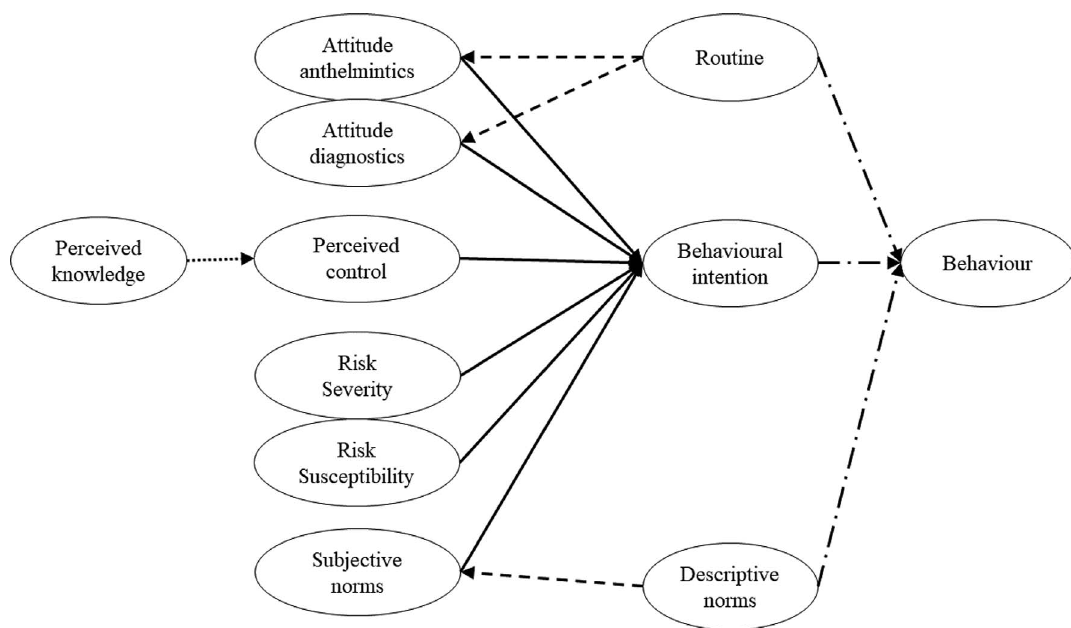
Figure 1. Conceptual model to predict dairy farmers ’ adoption of diagnostic methods for control of gastrointestinal nematode infections, based on the work by Vande Velde et al. (2015), and extended with insights from previous decision-making frameworks for parasite control. Notes. Full lines represent the equations informed by Vande Velde et al. (2015), dotted lines by Rose Vineer et al. (2017), short-dashed lines by Mingolla et al. (2019), dashed-dotted lines by Vande Velde et al. (2018). The following factors are included: Perceived knowledge (i.e., perception of the current knowledge one has on the context of control of gastrointestinal nematode infections); Perceived control (i.e., perceived ability to adopt diagnostics for control of gastrointestinal nematode infections); Routine (i.e., perception of the current treatment); Attitude diagnostics (i.e., evaluation of the expected outcomes to adopt diagnostics for control of gastrointestinal nematode infections); Attitude anthelmintics (i.e., evaluation of the expected outcomes to preventively treat with anthelmintics for control of gastrointestinal nematode infections); Descriptive norms (i.e., perception of peers that actually perform a diagnosis for control of gastrointestinal